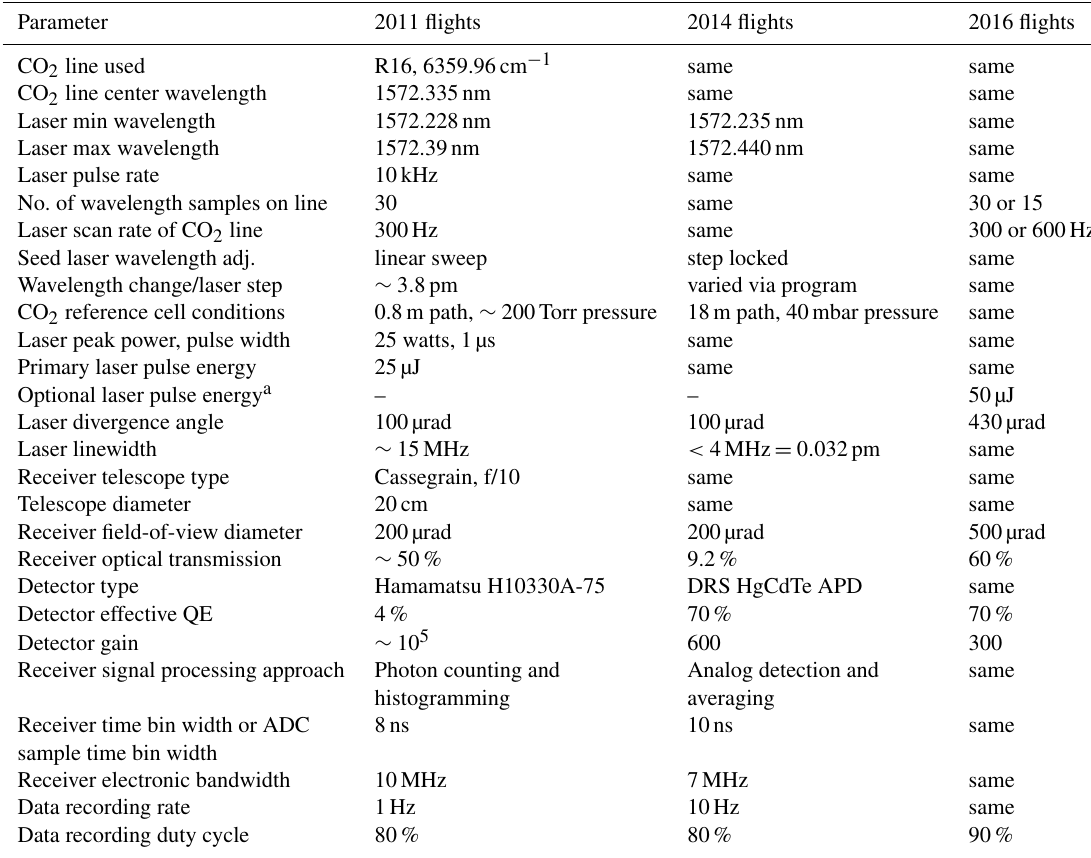
Table 1. CO 2 Sounder lidar parameters for the 2011, 2014 and 2016 airborne campaigns. Parameter 2011 flights CO 2 line